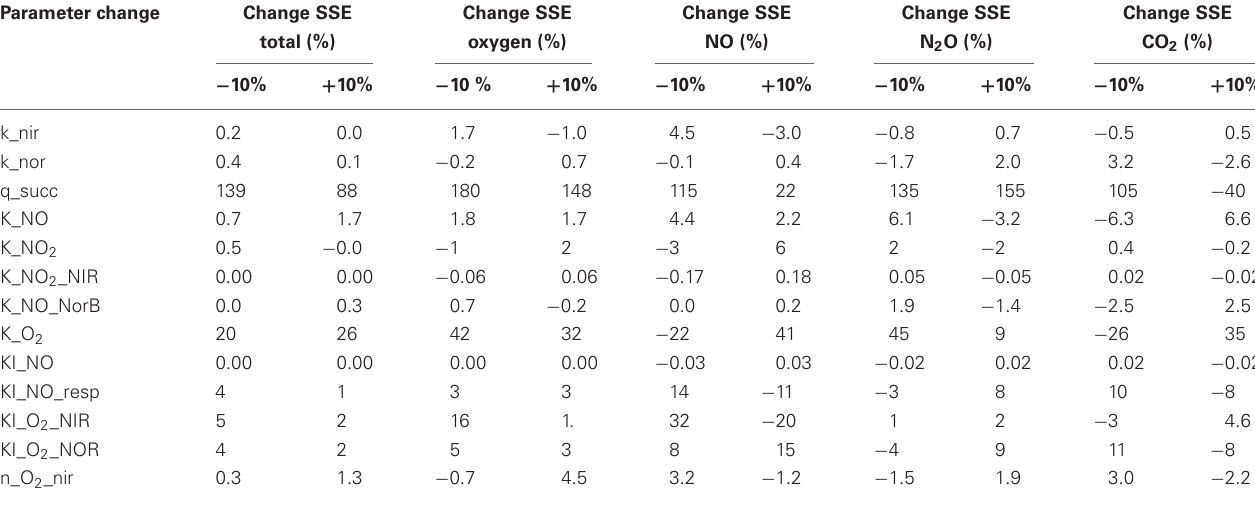
Table 2 | Normalized change (%) in sum of squared errors for the parameters in the metabolic model. Parameter